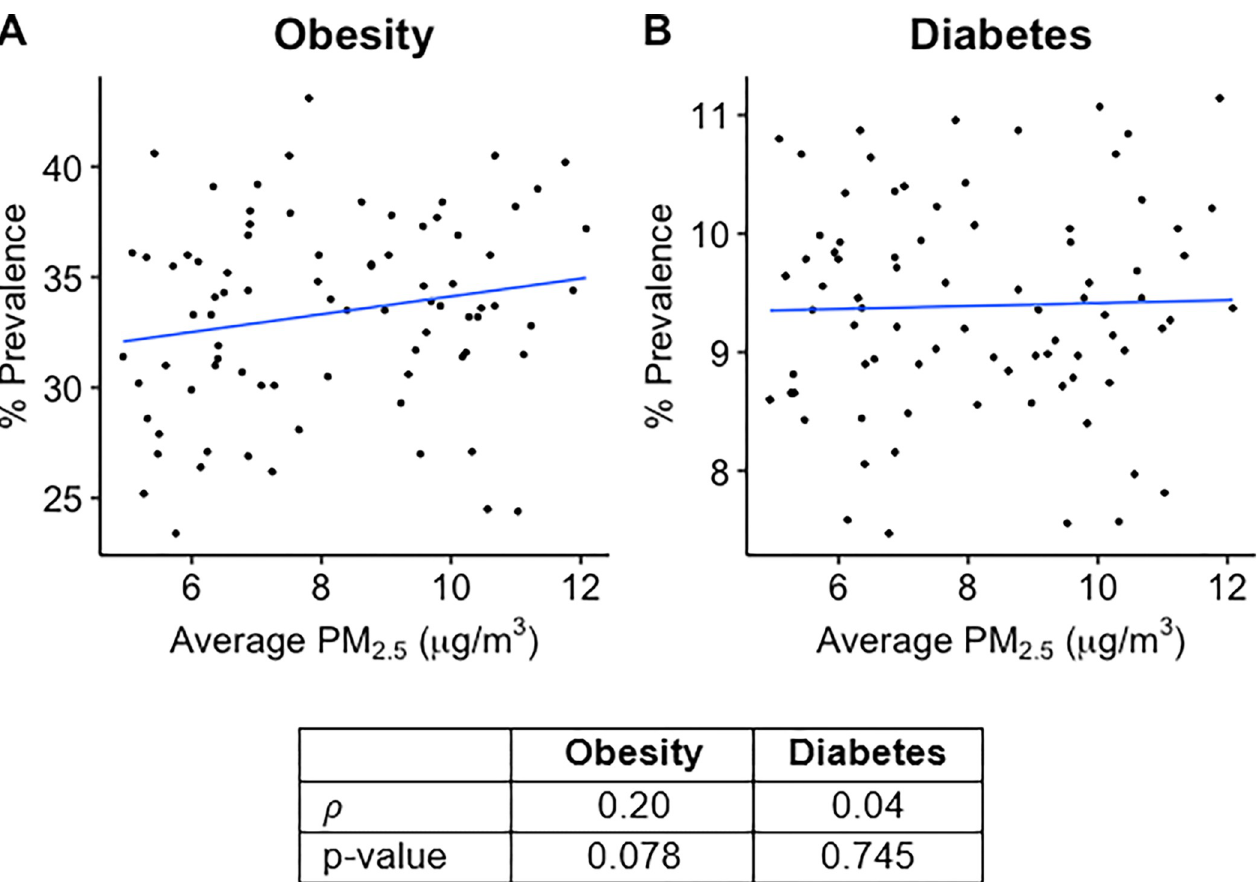
Fig 2. Scatterplots showing average PM 2.5 (x axis) vs. Prevalence Rate (y axis) for: A. Diabetes and B. Obesity. Prevalence Rates are shown as a percentage value. Individual points represent average values for each of the 82 counties included in the study. Best fit line for each plot was obtained by simple linear regression. Table shows Spearman rank correlation coefficient ( ρ ) calculated for each plot as well as the p-value for each correlation coefficient. P-values < 0.05 are statistically